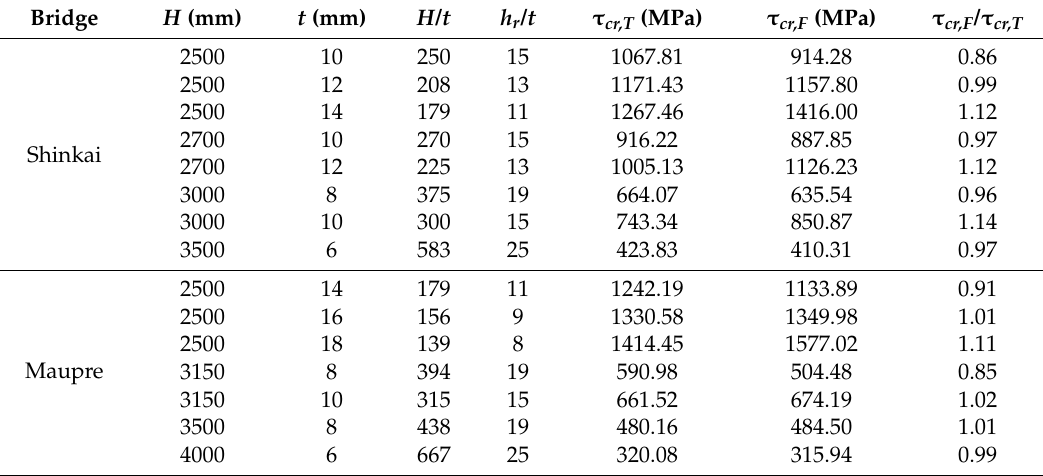
Table 4. Global elastic shear buckling strength of PCCSW with varying height and thickness for R = 110 m. AVE: average value; COV: